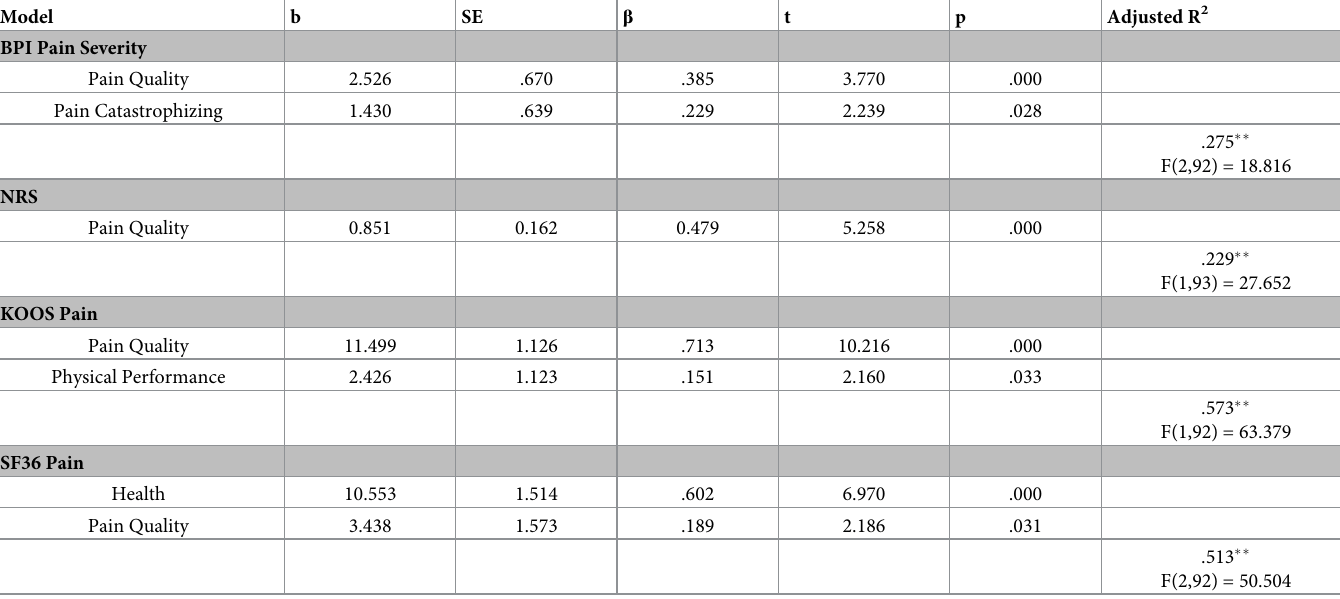
Table 3. Multiple regression models for KOA pain intensity at baseline for four different pain intensity measures.